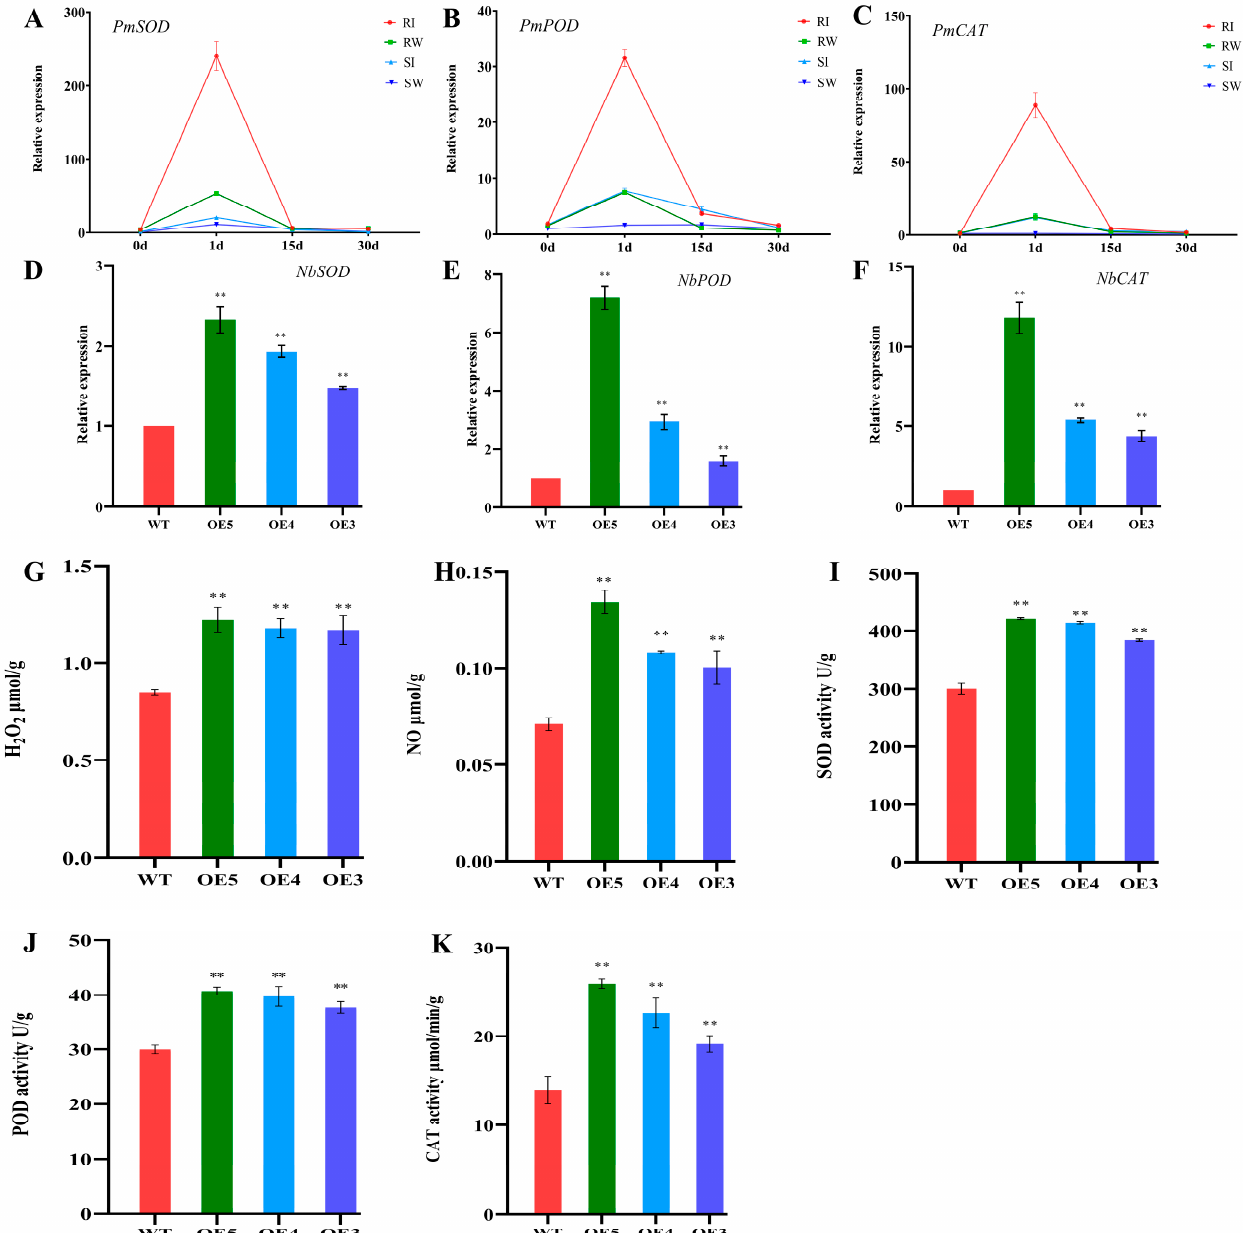
Figure 6. Physiological differences between P. massoniana and tobacco. ( A – C ) Expression patterns of PmSOD , PmPOD , and PmCAT in resistant and susceptible P. massoniana inoculated with the PWN at 0, 1, 15, and 30 dpi. Error bars represent three biological replicates ± SD. RI and RW represent resistant P. massoniana inoculated with the PWN and water, respectively; SI and SW represent susceptible P. massoniana inoculated with the PWN and water, respectively. Susceptible P. massoniana at 0 days of water inoculation served as a control. ( D – F ) Differences in the relative expression levels of NbSOD , NbPOD , and NbCAT in WT and transgenic tobacco. ( G – K ) The contents of H 2 O 2 , NO, SOD, POD, and CAT were different between WT and PmNBS-LRR97 -overexpressing tobacco. Error bars represent three biological replicates ± SD. The difference was statistically significant by Student’s t -test analysis (**, p < 0.01).